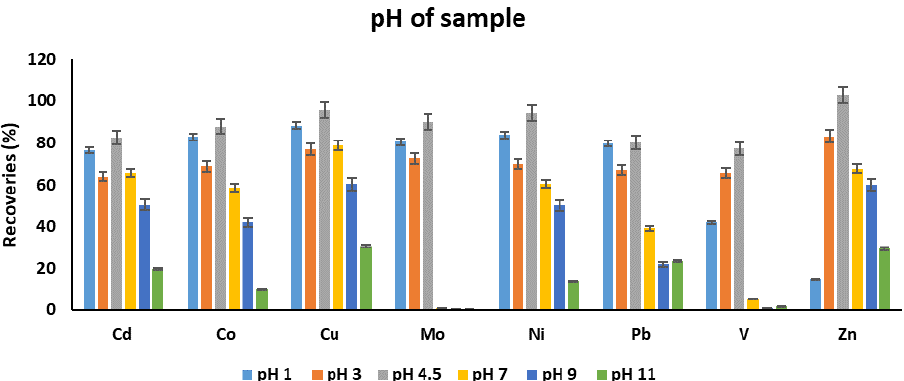
Figure 5. The effect of pH variation on the recoveries of target metals. Experimental conditions: volume of complexing reagent: 200 µL, volume of extraction solvent: 7.5 mL, extraction solvent: chloroform, extraction time: 30 min.